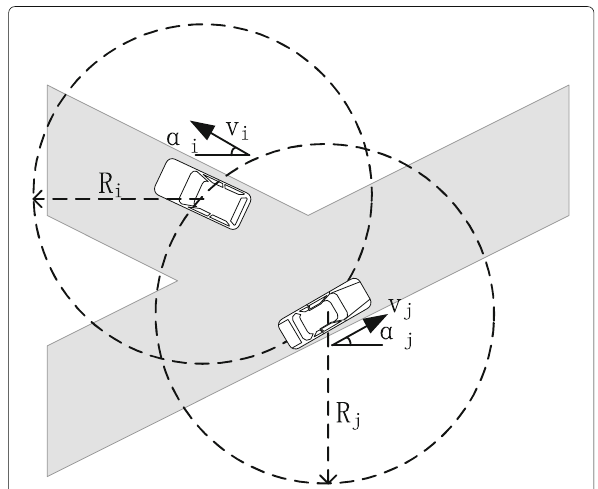
Fig. 3 Schematic diagram of adjacent vehicle